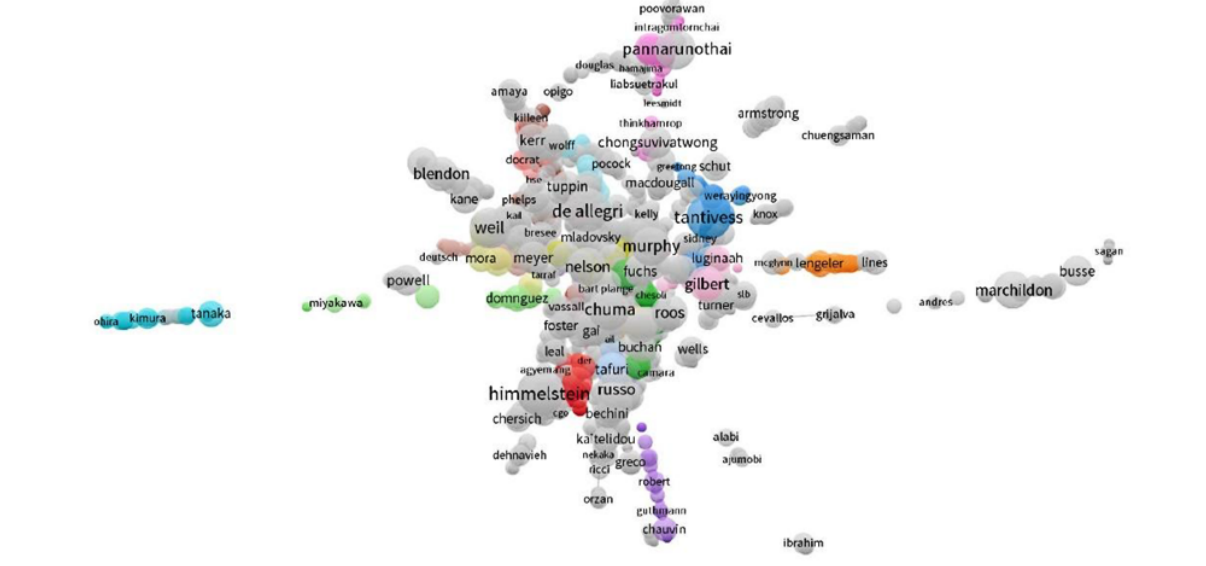
Figure 1. The distribution of authors publishing research in the field of universal health